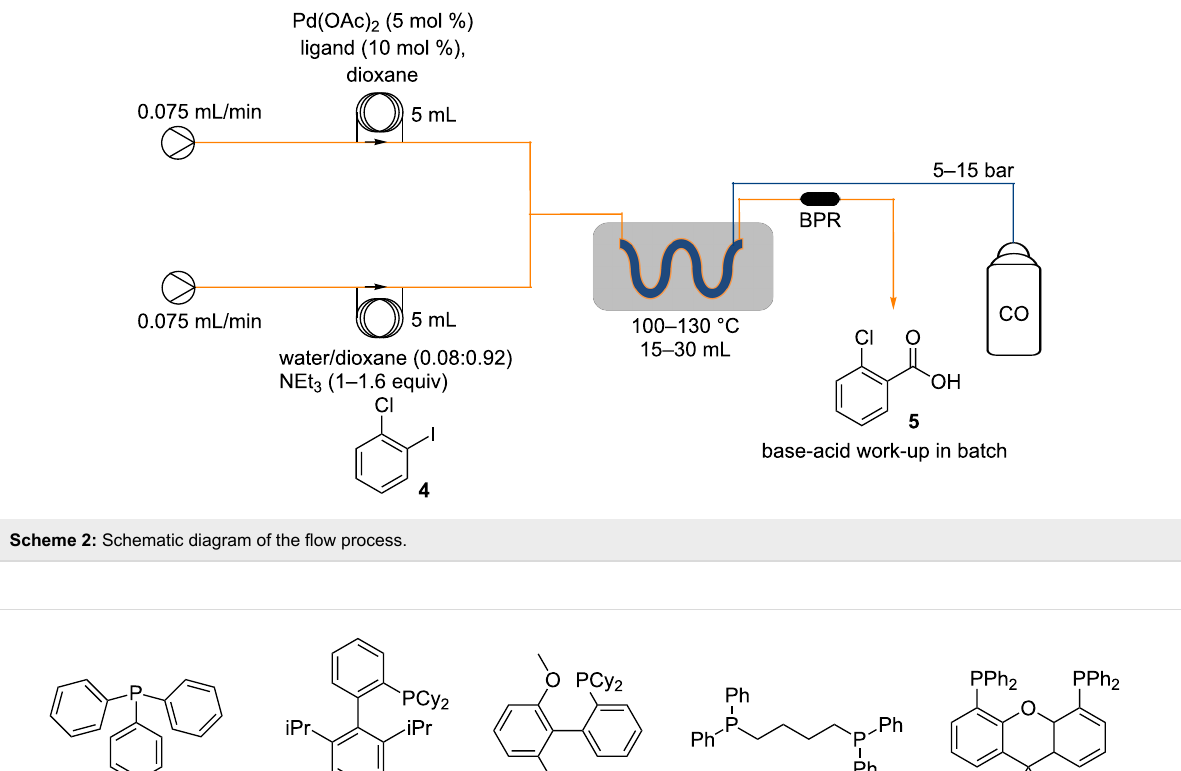
Figure 4: Phosphine ligands used for the ortho -carbonylation reaction.